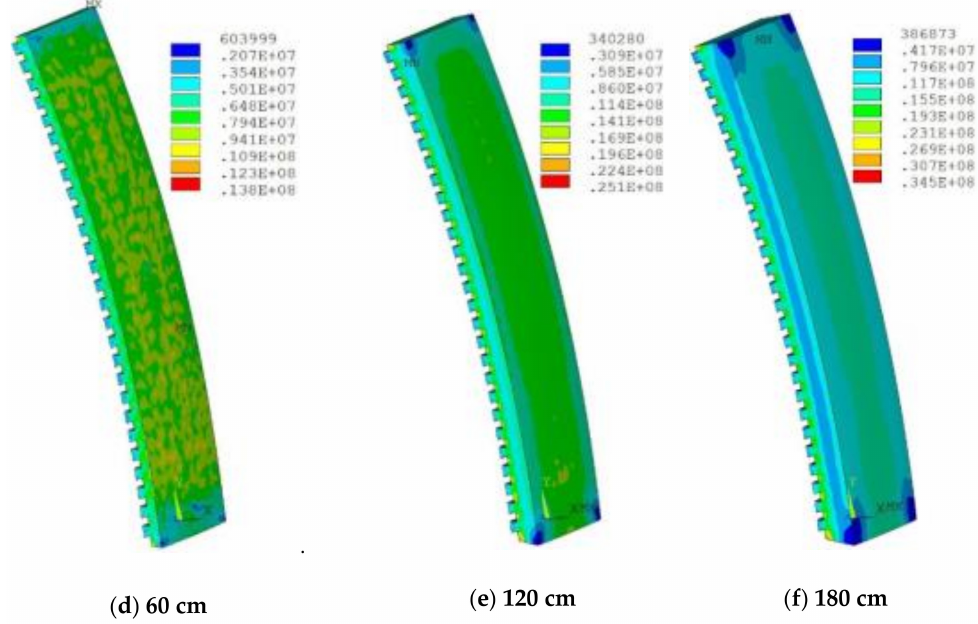
Figure 13. Stress (Pa) distribution of refractory bricks under different thicknesses.